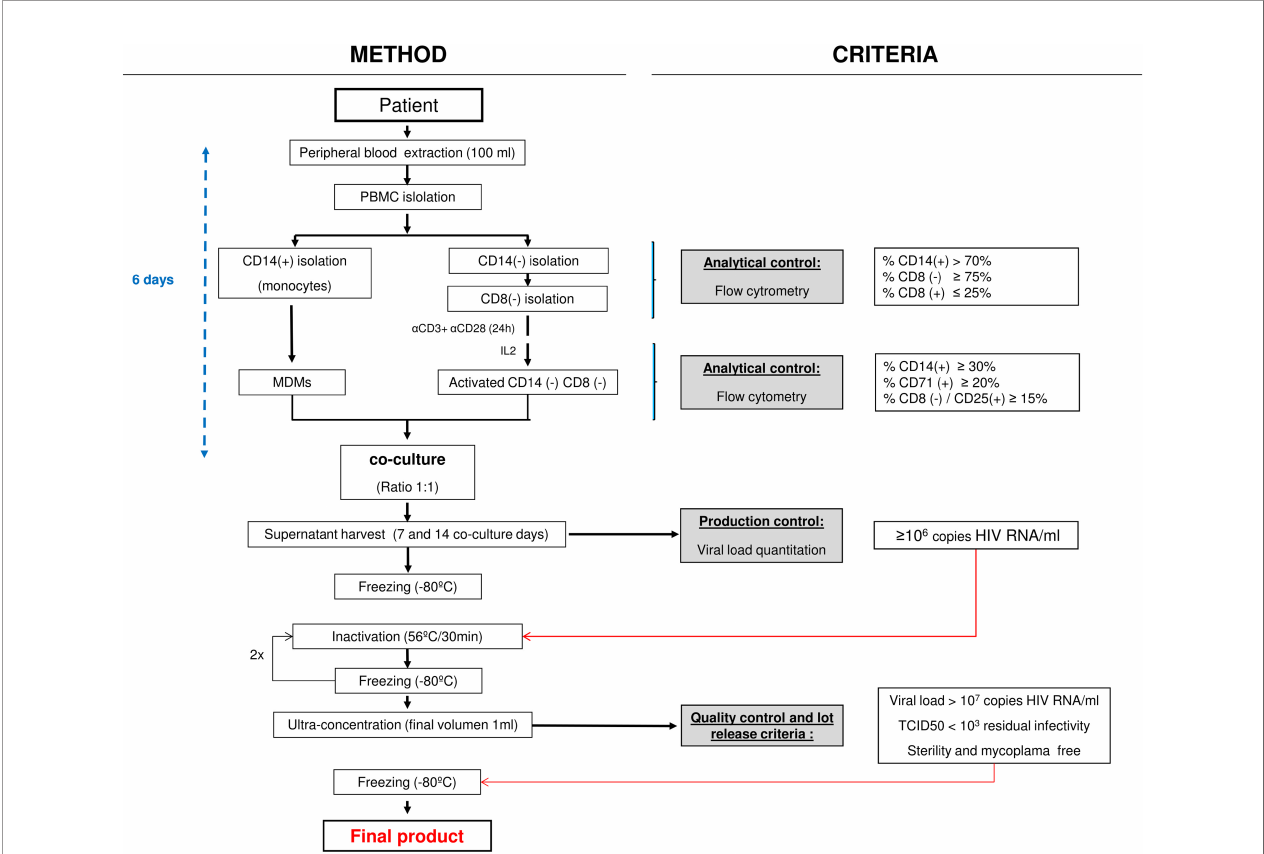
FIGURE 1 | GMP HIV-1 autologous production process fl owchart. Light gray boxes show the quality control steps required. Empty boxes on the right describe the Investigational Medicinal Product Dossier (IMPD)-based criteria applied. GMP, good manufacturing practice; PBMC, peripheral blood mononuclear cell; MDM, monocyte-derived